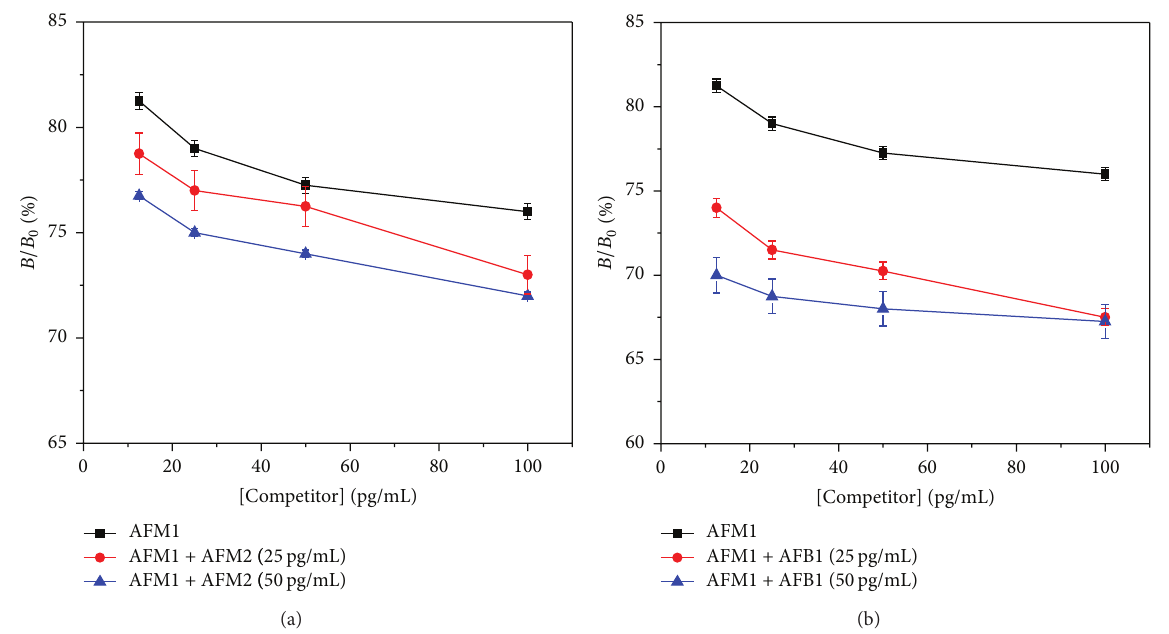
Figure 7: Mixture analysis by fluorimetric immunoassay: (a) AFM1 and AFM2 and (b) AFM1 and